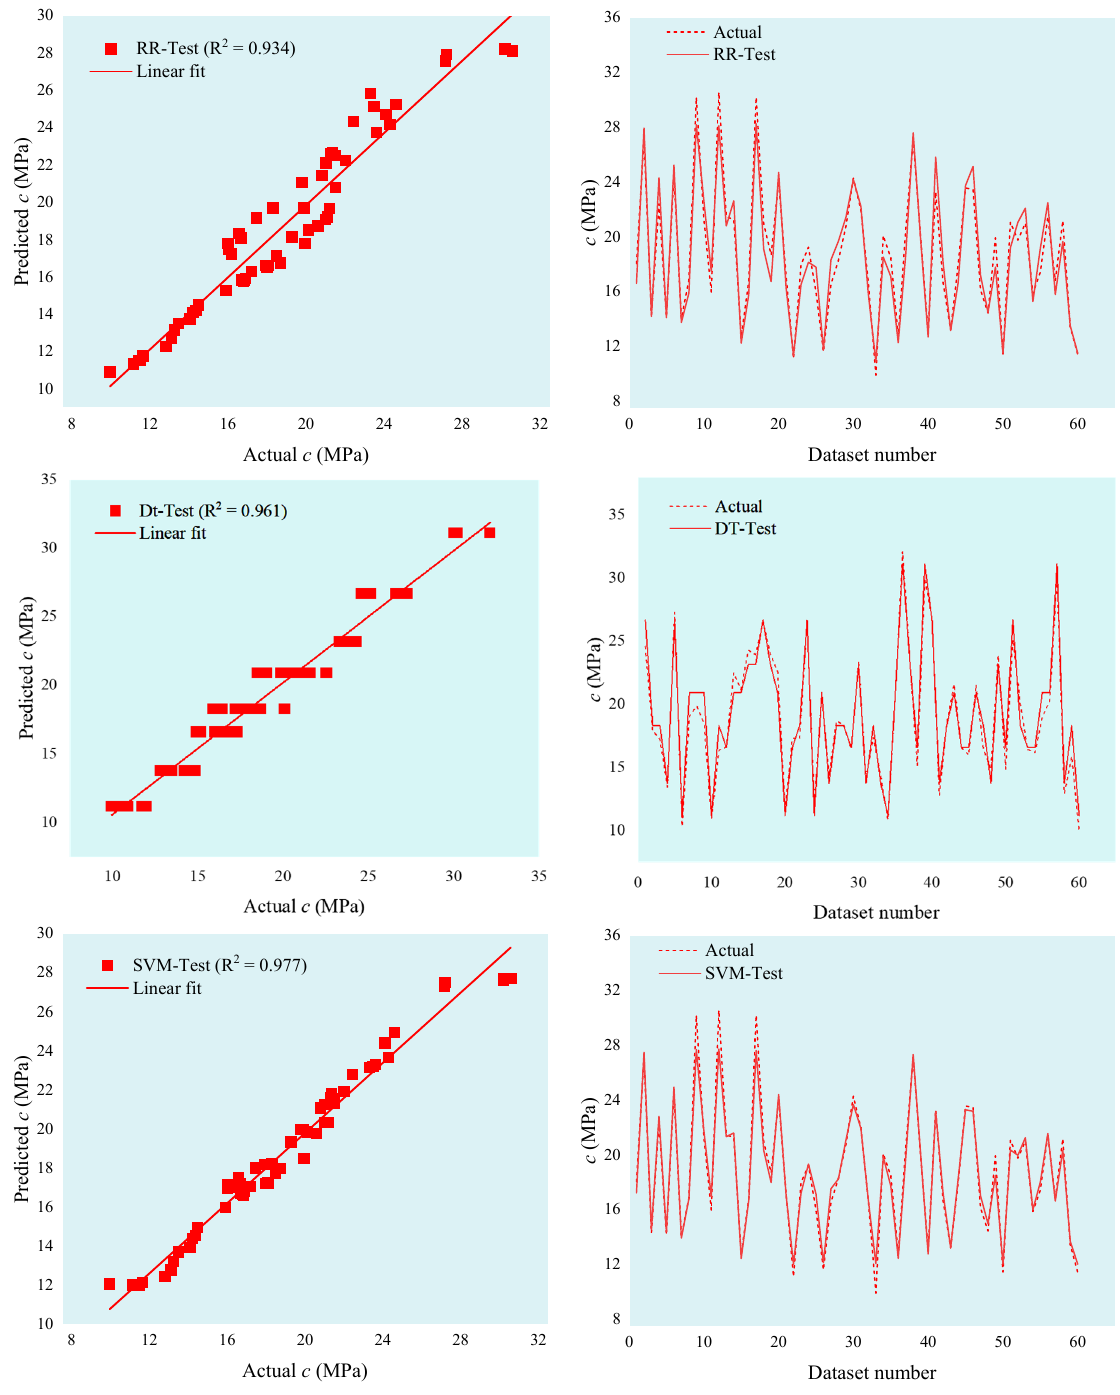
Figure 5. Performance plots of LR, RR, DT, and SVM models for the c (MPa) at the testing level. The data were split into two parts by DT, as shown in Figures 6 and 7. By averaging the two closest leaves, the similarity score and gain were computed, and the residuals were then transferred to the leaf with the maximum score and gain. The learning rate and maximum depth were set to 1.0 and 3.0, respectively, to prevent model complexity. Once the prediction results (residuals) were obtained, all data points were run through the model to produce h(x) and F(x) predictions.